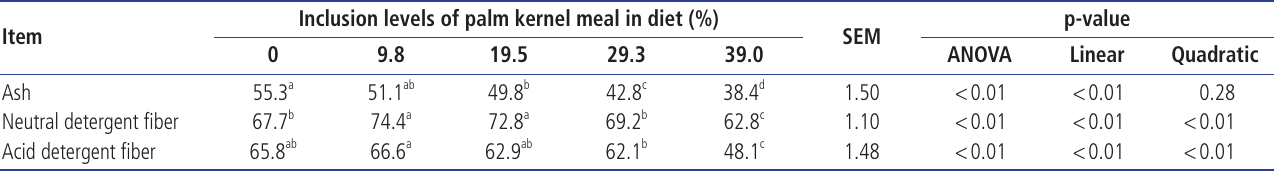
Table 4. Effects of inclusion levels of palm kernel meal on the apparent total tract digestibility (ATTD, %) of ash, neutral detergent fiber (NDF), and acid detergent fiber (ADF) in diet, regardless of the effect of adaptation duration 1),2)